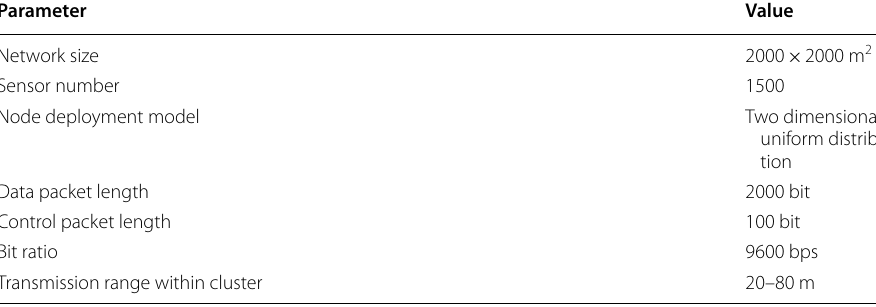
Table 1 The parameter of CMBC protocol